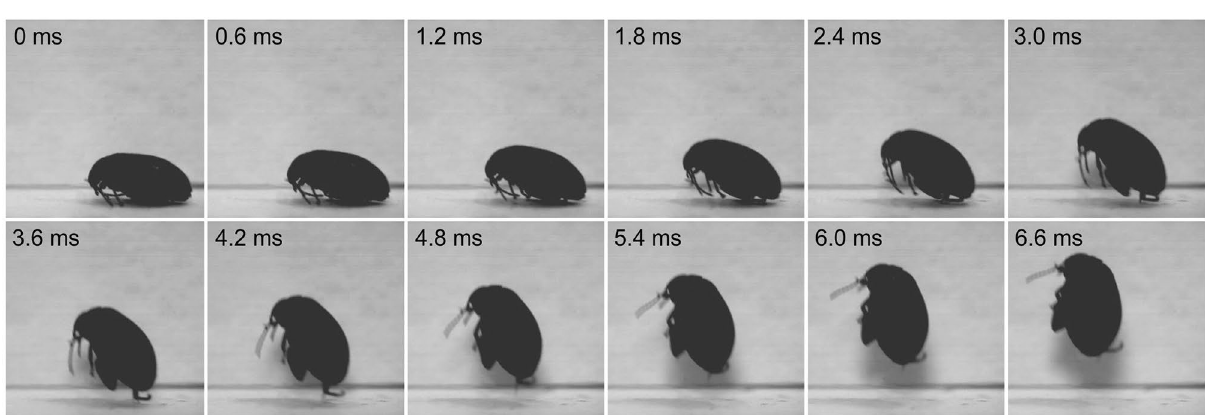
Figure 5. Frame-by-frame depiction of the jump of the marsh beetle Scirtes hemisphaericus . Jump is elicited by two hind legs, 3000 frames s −1 . The position of the left hind leg is indicated by the white line.